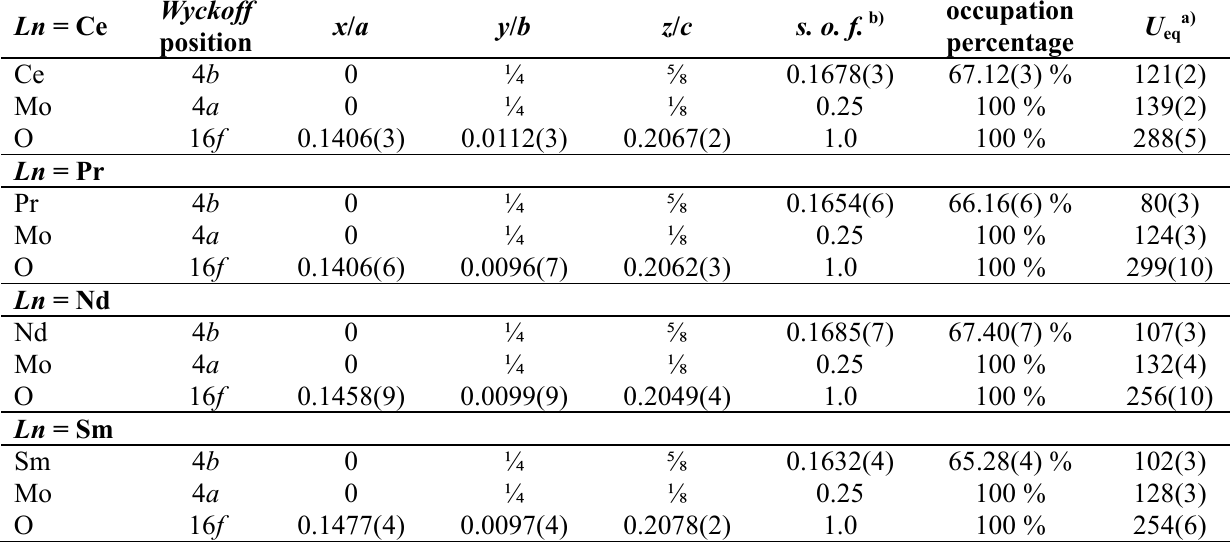
Table 1. Fractional atomic coordinates, site occupation probabilities, and coefficients of a) /pm 2 ) in the crystal structures of the the equivalent isotropic displacement parameters ( U eq scheelite -type series Ln [MoO ] ( Ln = Ce, Pr, Nd, and Sm). 0.667 4